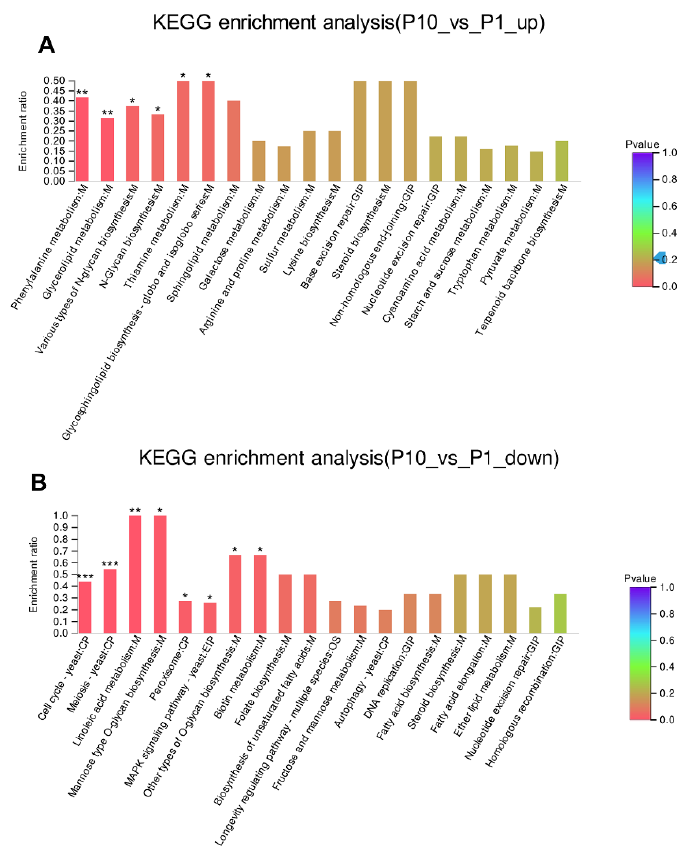
Figure 4. KEGG enrichment of the up-regulated ( A ) and down-regulated ( B ) DEPs. * p -value < 0.05, < 0.01, *** p -value < ** p -value < 0.01, *** p -value < 0.001. ** p -value